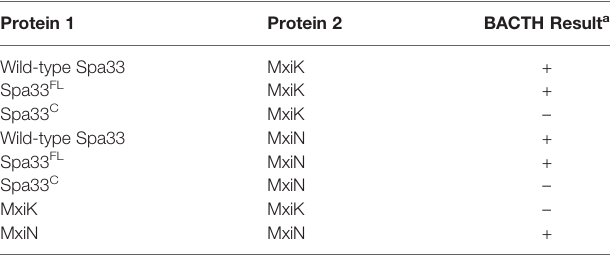
TABLE 4 | Interactions of MxiK and MxiN with Spa33 and the individual components of the Spa33